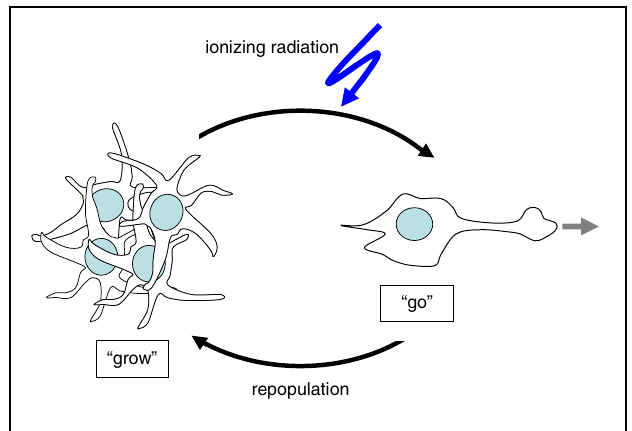
FIGURE 1 | Cellular stress such as ionizing radiation induces the switch from “Grow” to “Go” phenotype.